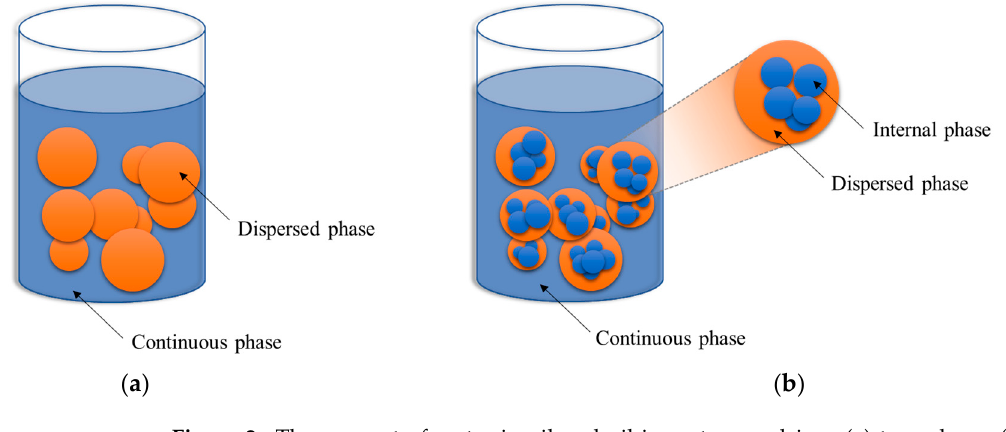
Figure 2. The concept of water-in-oil and oil-in-water emulsion: ( a ) two-phase; ( b ) three-phase (adopted from [54]).